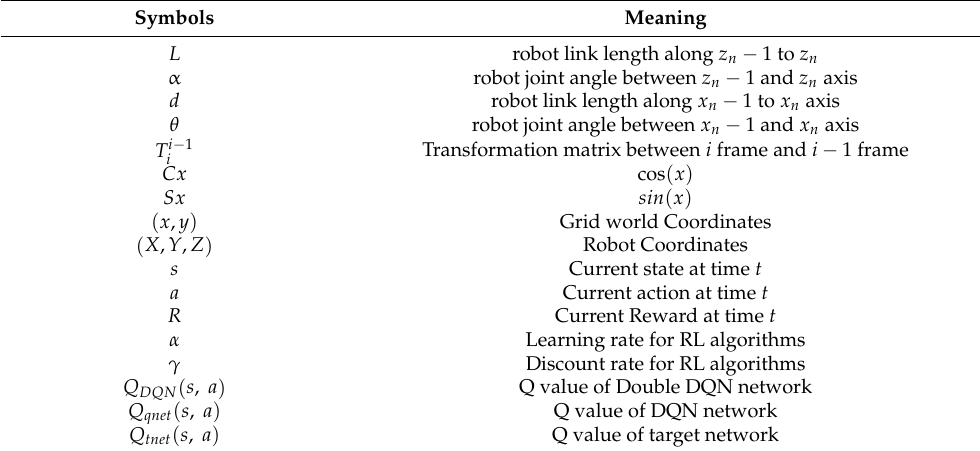
Table A2. List of Mathematical Symbols Used.